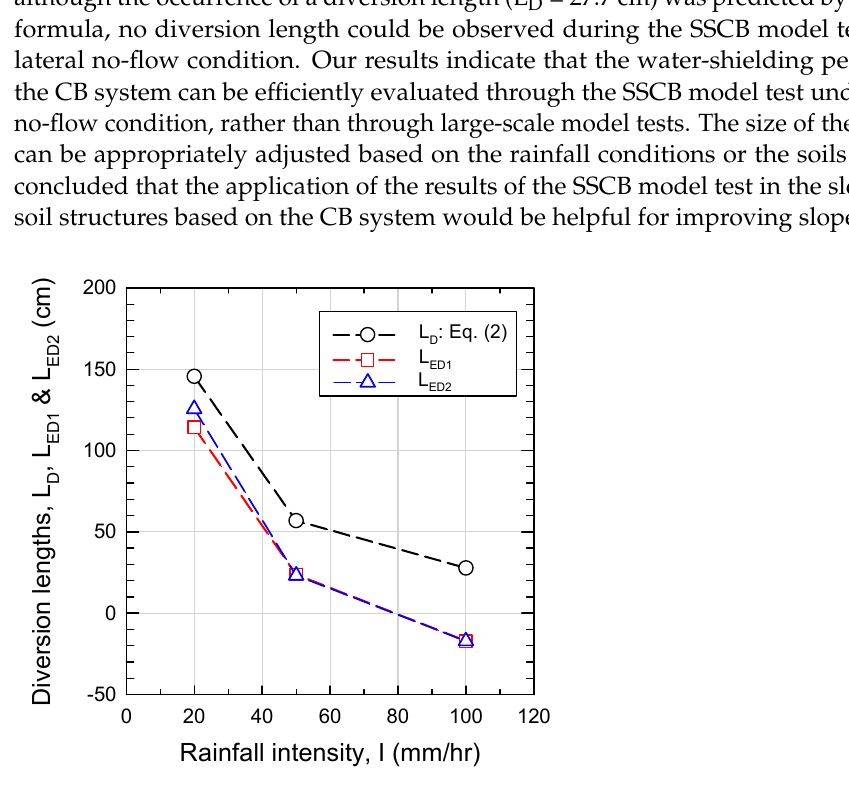
Figure 11. Comparison of the diversion lengths based on the SSCB model test under the lateral no-flow condition and estimated by the empirical equation.